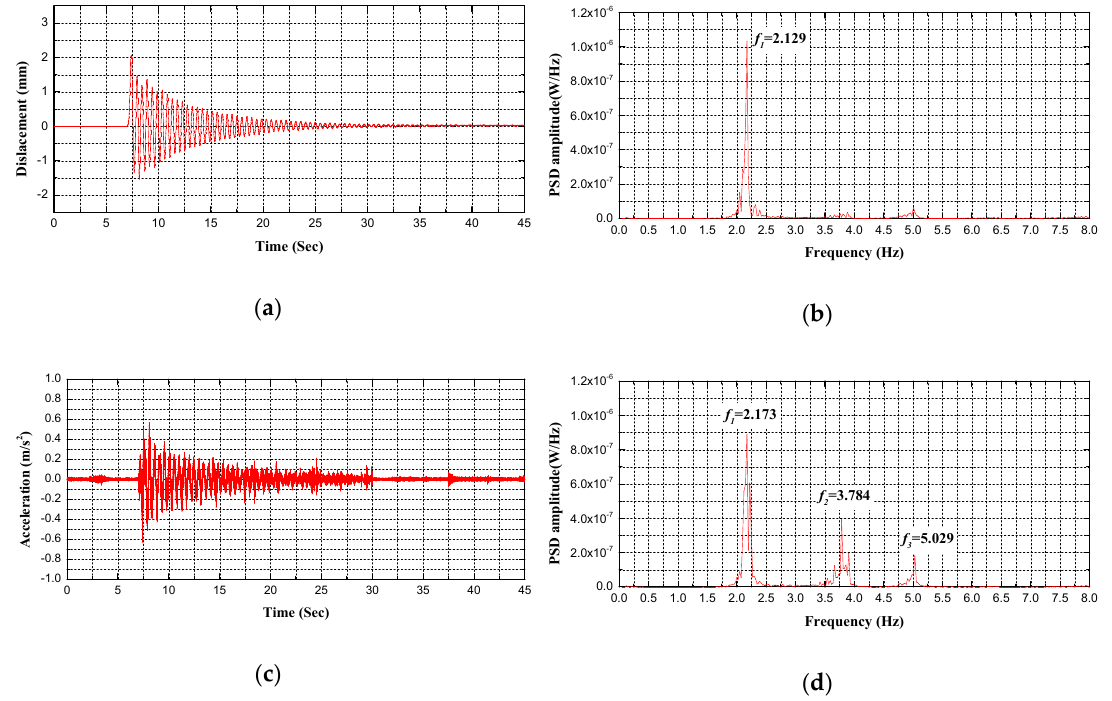
Figure 14. Comparison between measured frequencies for B1 test condition: ( a ) displacement response measured by holographic visual sensor (HVS); ( b ) the power spectral density (PSD) of displacement response measured by HVS; ( c ) acceleration signal measured by accelerometer; ( d ) the PSD of acceleration signal measured by accelerometer.